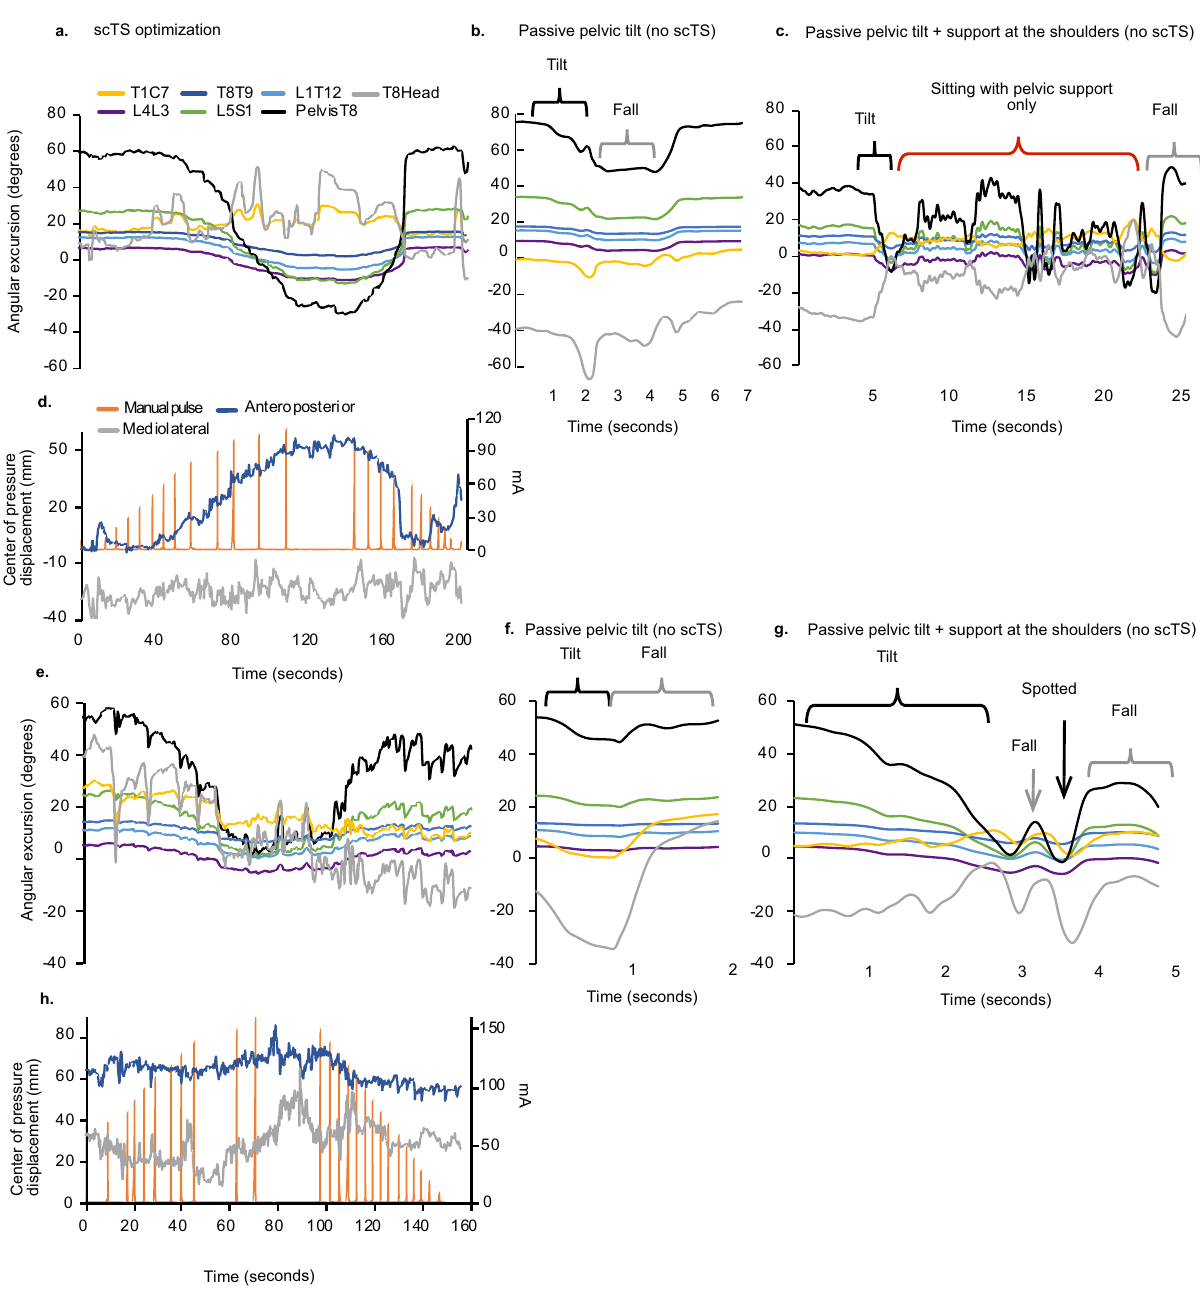
Fig. 2 Sitting posture during transcutaneous spinal cord stimulation (scTS) vs. passive pelvic tilt in children with SCI. Segmental trunk kinematics during scTS optimization for representative participants P14 ( a ) and P23 ( e ). Anteroposterior and mediolateral center of pressure displacements (millimeters, (mm)) were recorded concomitant with kinematics P14 ( d ), P23 ( h ). Manual pulse indicates the increase of stimulation intensity in 10 milliamp (mA) increments. Trunk kinematics during passive pelvic tilt was performed by a physical therapist without scTS while participants were seated relaxed, P14 ( b ) and P23 ( f ). Black curly bracket indicates the attempt to shift pelvis from posterior tilt toward neutral position, gray curly bracket indicates participants response of falling forward. Additional support at the anterior aspect of the shoulders was then provided by another therapist during passive pelvic tilt for P14 ( c ) and P23 ( g ). The participants were instructed to maintain upright posture after the shoulder support was removed with just the pelvic support. The red curly bracket indicates the participant ’ s P14 attempt to stay upright ( c ). Participant P23 was not able to maintain balance once shoulder support was removed ( g ). Gray arrow points to the perturbation in trunk kinematics at the initial fall. The participant was spotted (black arrow) and repositioned to upright posture which P23 could not maintain, falling forward again when shoulder support was ( p = 0.03), PelvisT8 was signi fi cantly more extended during ( p = 0.0002). T8Head and T1C7 segments were signi fi cantly L1 scTS as compared to BL ( p < 0.0001) and VA ( p < 0.0001), and more extended during VA as compared to L1 scTS ( p < 0.0001 T8Head was signi fi cantly more extended during L1 scTS as and p = 0.047, respectively). There were no signi fi cant timepoint compared to BL ( p = 0.002) and during VA as compared to BL differences in other trunk segments. There was a signi fi cant